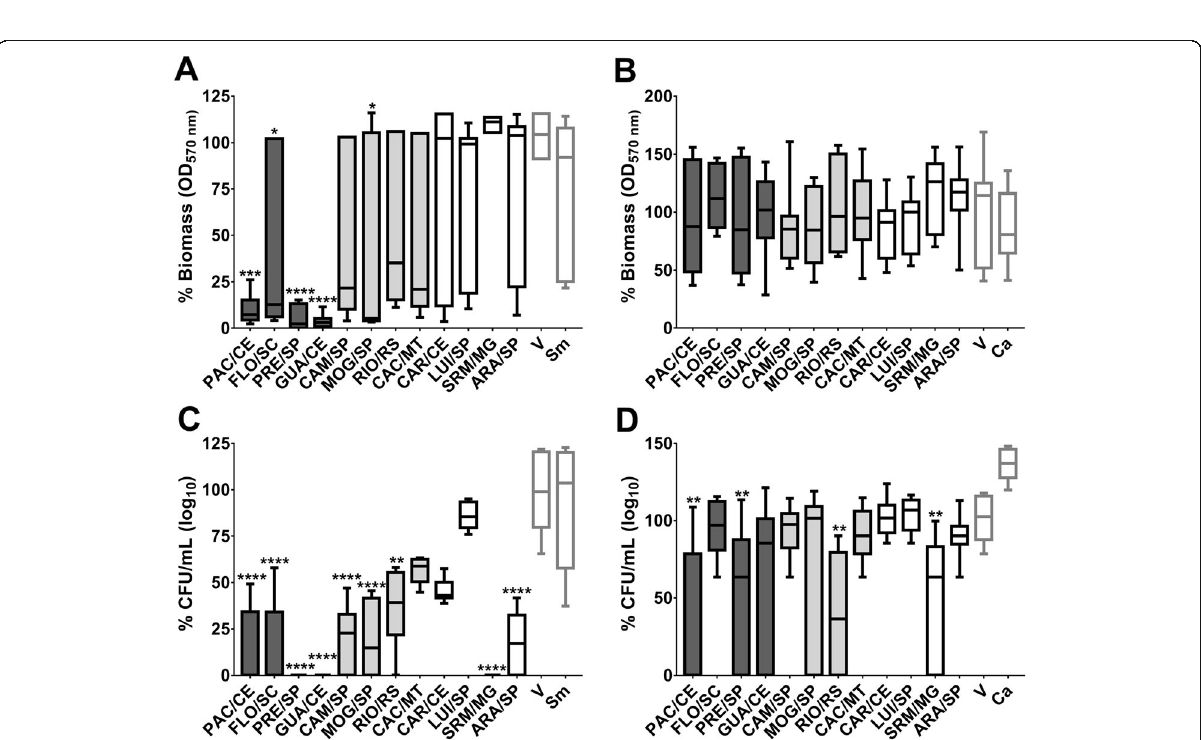
Fig. 4 Antibiofilm activity of C. sylvestris extracts from Brazilian biomes against S. mutans and C. albicans . The biomass data obtained via violet crystal method are shown in ( a ) and ( b ) for S. mutans and C. albicans , respectively. The microbial viable counts data are shown in ( c ) and ( d ) for S. mutans and C. albicans , respectively. Note that the extracts presented more effect against S. mutans biofilms than against C. albicans ones. The data described are median (traces) and interquartis (boxes) of the 12 tested extracts. The error bars represent the maximum and minimum values.Asterisks denote statistically significant difference of a specific extract versus vehicle (V) control, where: **** p ≤ 0.0001; *** p ≤ 0.001; ** ≤ p < 0.01; and * p ≤ 0.05 (Kruskal-Wallis test, followed by Dunn ’ s multiple comparisons test). Each species growth control is represented as Sm for S. mutans and Ca for C. albicans . The colors of the bars of the graph represent the variety to which the extracts belong, being, in dark gray color: var. sylvestris ; light gray: var. intermediate and white: var .